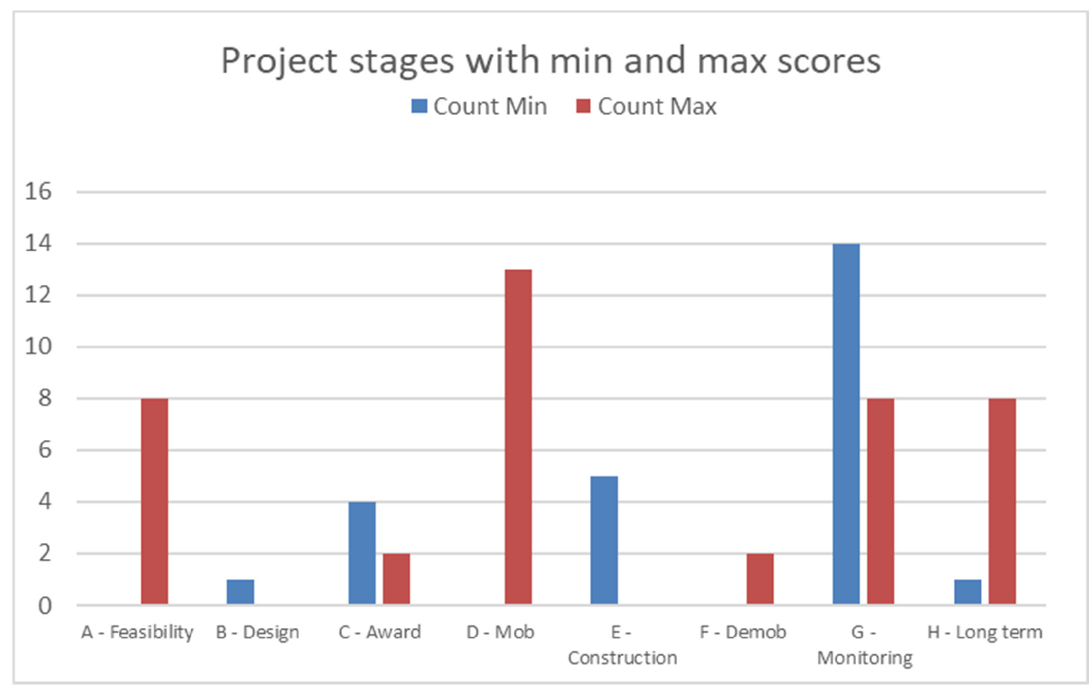
Figure 6. The least and most sustainable project stages as counted for each case study.